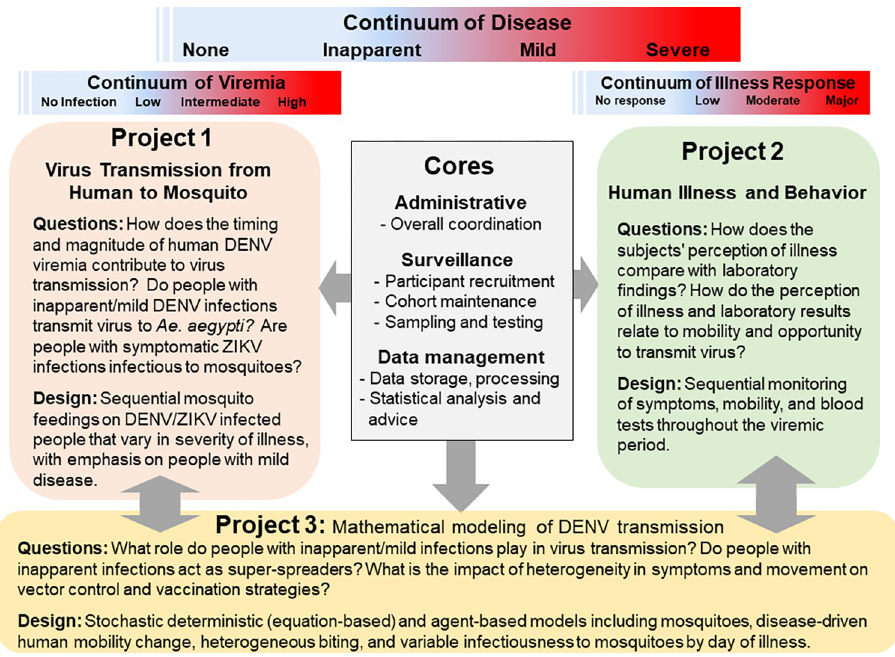
Fig 1. Project diagram showing the integration of the three projects and